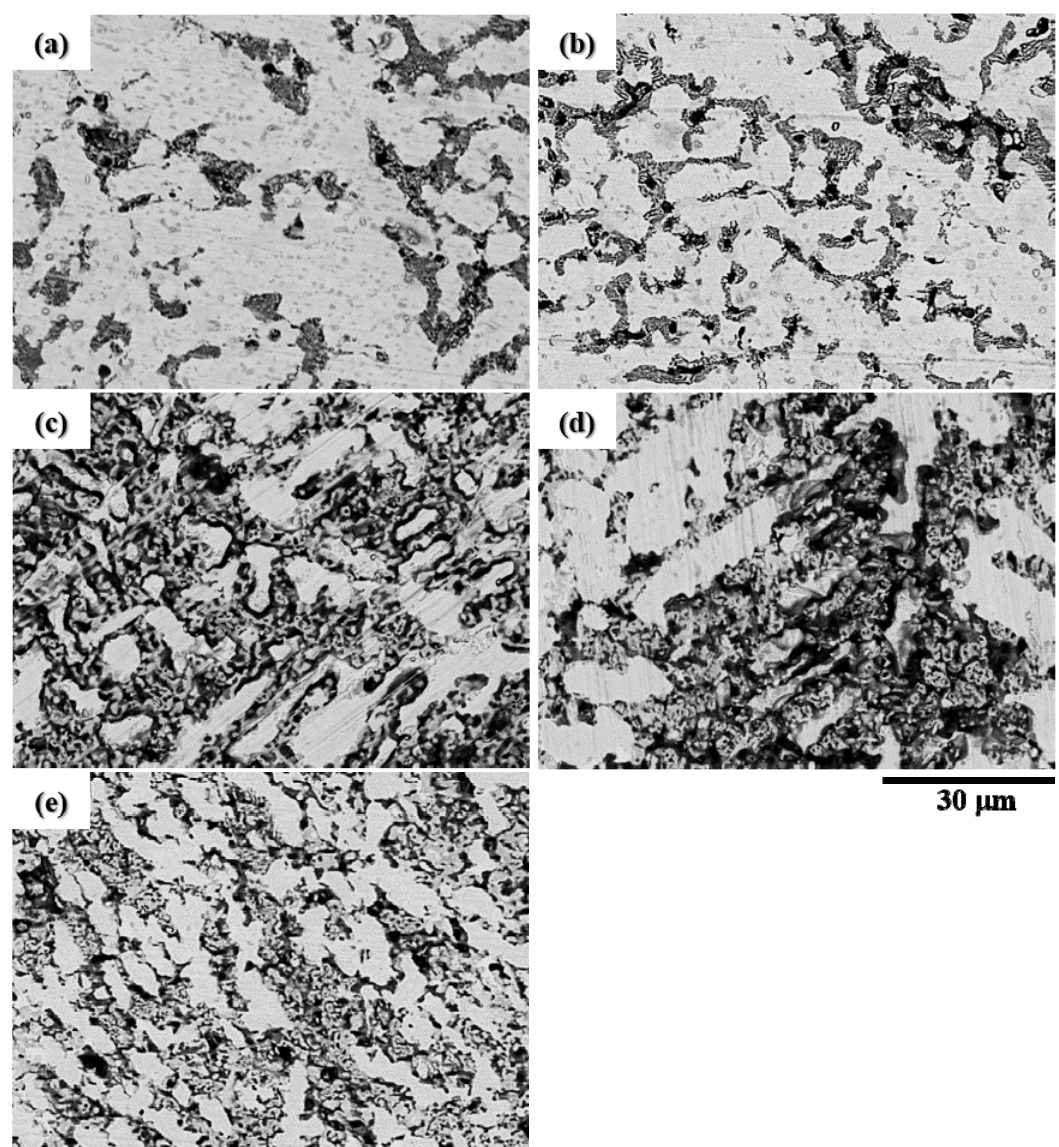
Figure 10. BEI surface morphologies of the CuFeTiZrNi x alloys after the polarization test in 3.5 wt.% NaCl solution: ( a ) x = 0.1, ( b ) x = 0.3, ( c ) x = 0.5, ( d ) x = 0.8, and ( e ) x = 1.0.